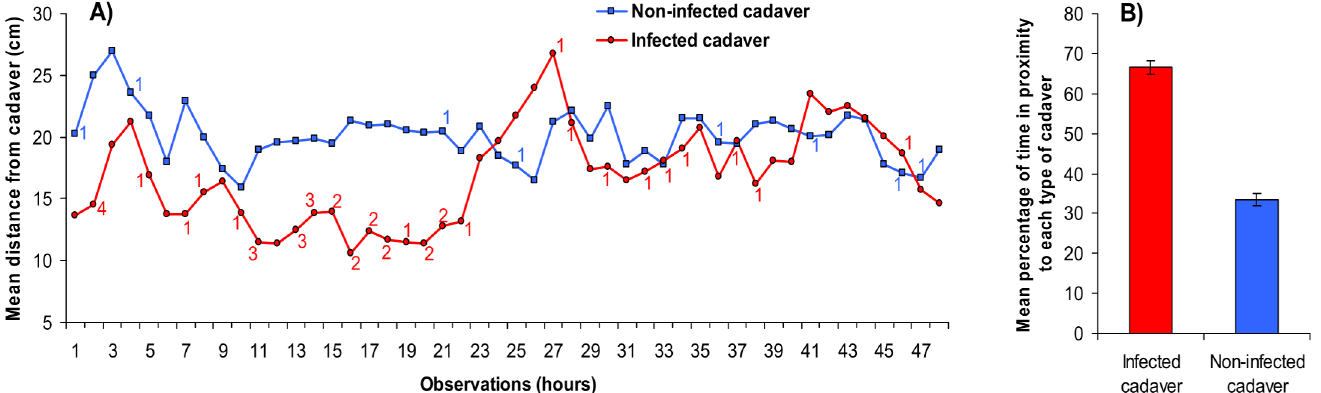
Fig 4. Mean distance between healthy larvae and infected or non-infected cadavers. a) Hourly means of observations performed over a 48 h period on each larva (n = 22 larvae). Points labeled with numerical values indicate number of acts of necrophagy observed at each time point (values shown in blue refer to necrophagy on non-infected cadavers, values in red refer to necrophagy on infected cadavers); b) Mean percentage of observations in which the experimental insect was closer to the infected (red column) or non-infected (blue column) cadaver. Vertical bars indicate